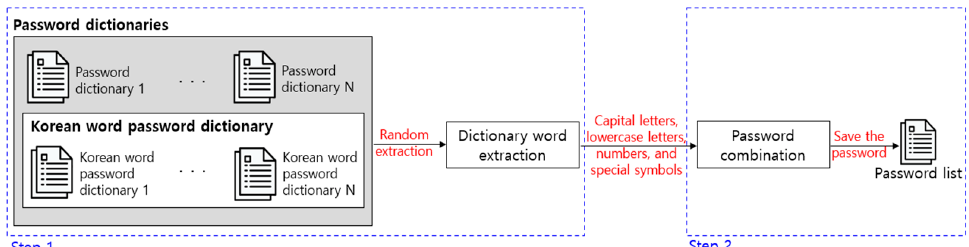
Figure 6. Process of creating a password list.